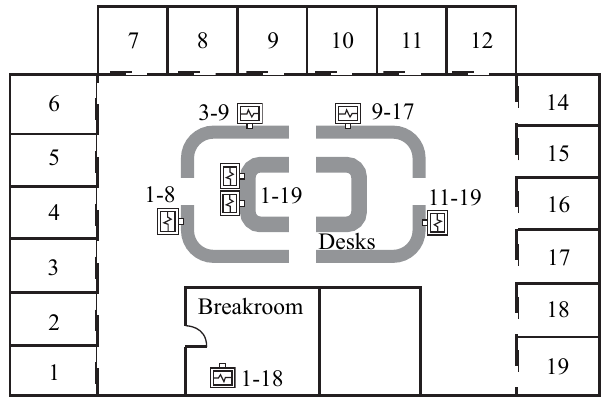
Figure 4. Mapping of monitors to rooms. There is one patient and monitor per room (not shown). The monitors on the outer desk typically show vitals from the six nearest patients. When an alarm occurs, all monitors sound the alarm, and display the corresponding raw data. Not drawn to scale. Table 4. Comparison of ordered logistic regression and tree models to identify acute patients. The low baseline p -values indicate that the models are more accurate than chance. The high Wilcoxon model comparison p -values indicate that the models are unlikely to differ in accuracy. “Meds” is short for Medication Quantity